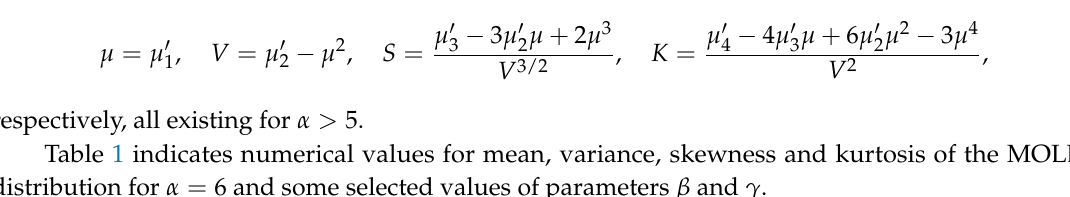
Table 1 indicates numerical values for mean, variance, skewness and kurtosis of the MOLBL distribution for α = 6 and some selected values of parameters β and γ . Table 1. Numerical values for mean, variance, skewness and kurtosis of the Marshall–Olkin length-biased Lomax (MOLBL) distribution for selected values of the parameters β and γ . ( β , γ ) µ V S K ( 50,100